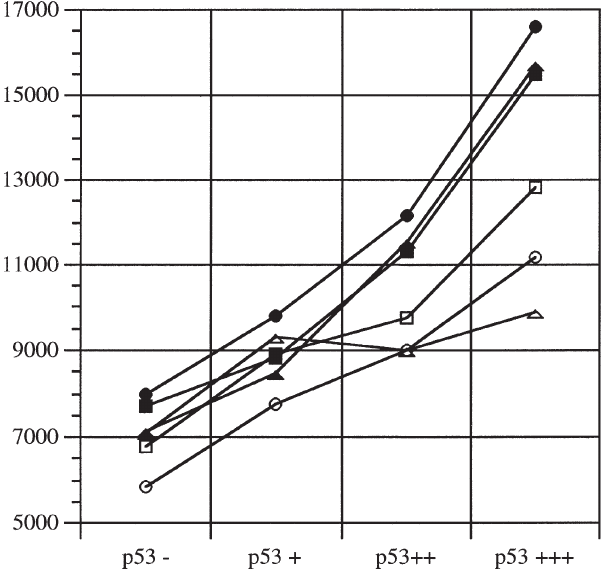
Fig. 4. Standard deviation of integrated optical density in nuclear subpopulations with different p53 expression in correlation to DNA ploidy, S-phase and G2M-fraction. p53 − . . . p53 negative nuclei; p53 + . . . weakly p53 positive nuclei; p53 ++ . . . moderatly p53 positive nuclei; p53 + + + . . . strongly positive nuclei. 1 peri-, di- and tetraploid; 2 aneuploid; ! S-phase < 5%; " S-phase > 5%; P G2M-fraction < 5%; Q G2M-fraction >